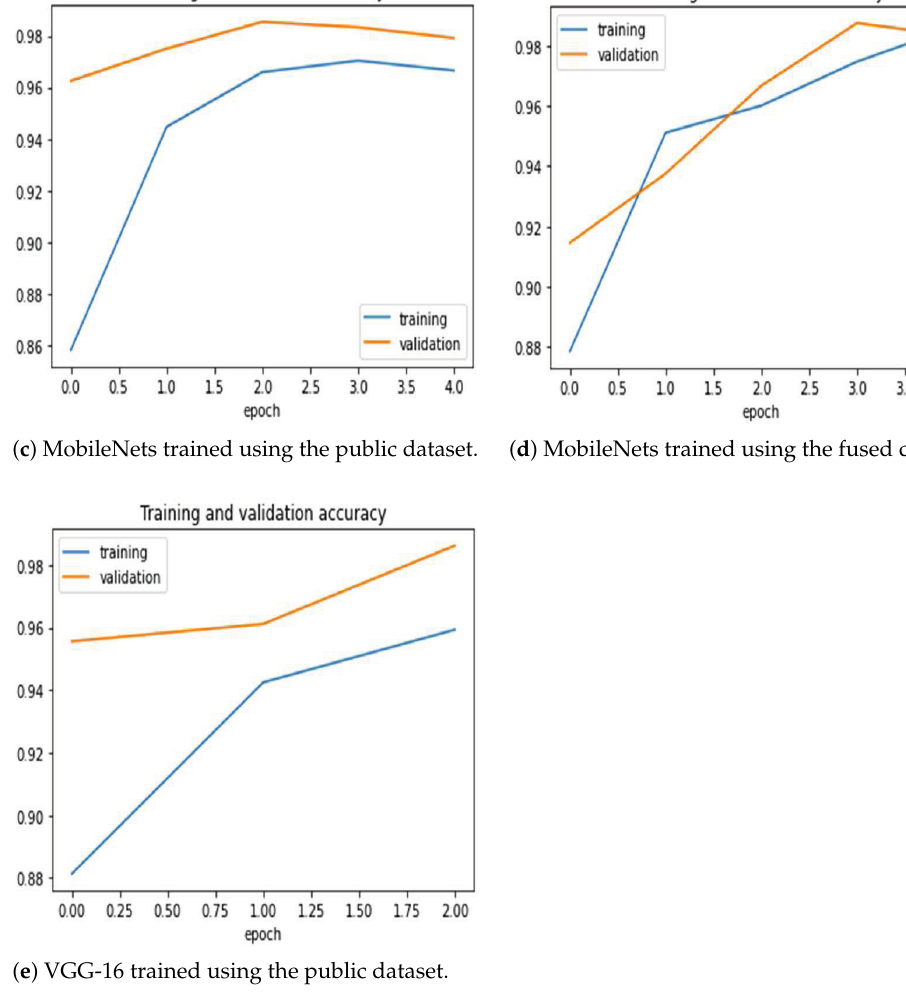
Figure 6. Training and validation accuracy for the three architectures trained using the public and the fused datasets. Note that VGG-16 trained on the fused dataset ended after one epoch only, hence there is no corresponding figure. The models are able to properly fit training data and improve with experience (as seen in validation